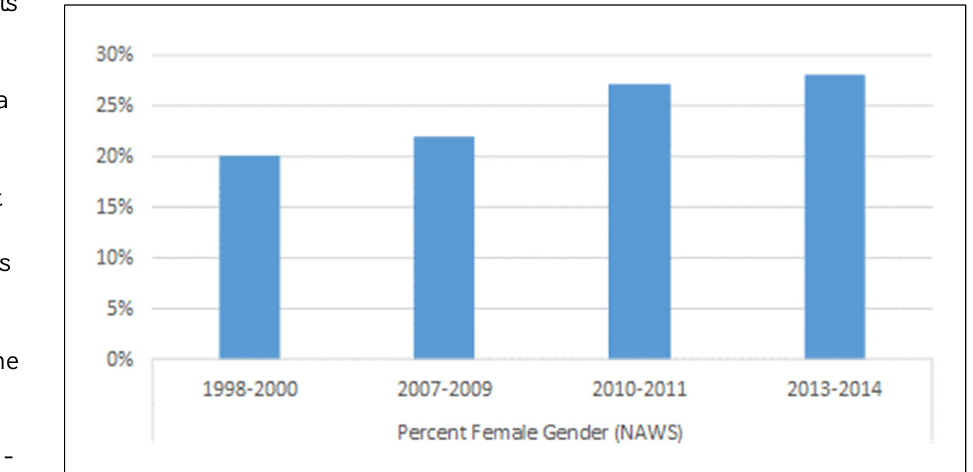
Data source: U.S. Department of Labor,